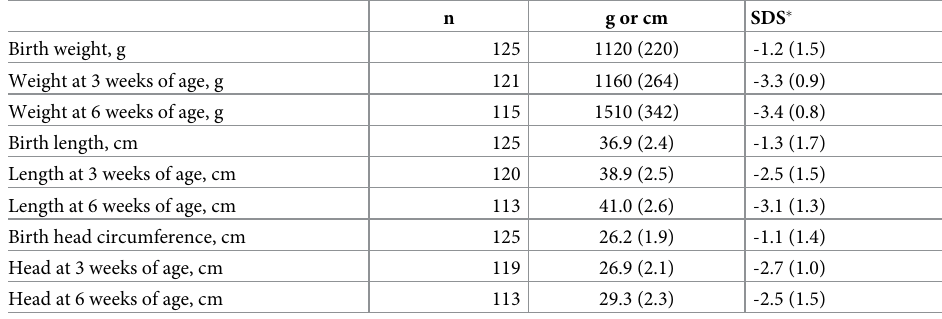
Table 3. Weight, length and head circumference at birth and at 3 and 6 weeks of